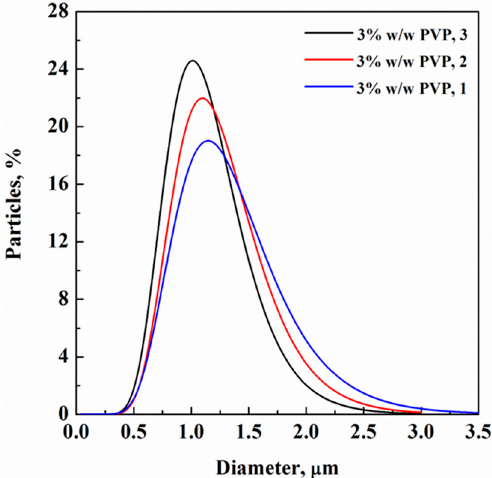
Figure 6. PSD of PVP particles at 3% w / w collected on (1) stainless-steel blocks in a plexiglass delimiter, (2) stainless-steel blocks and a metallic spiral and (3) stainless-steel blocks and a metallic spiral in a plexiglass delimiter.